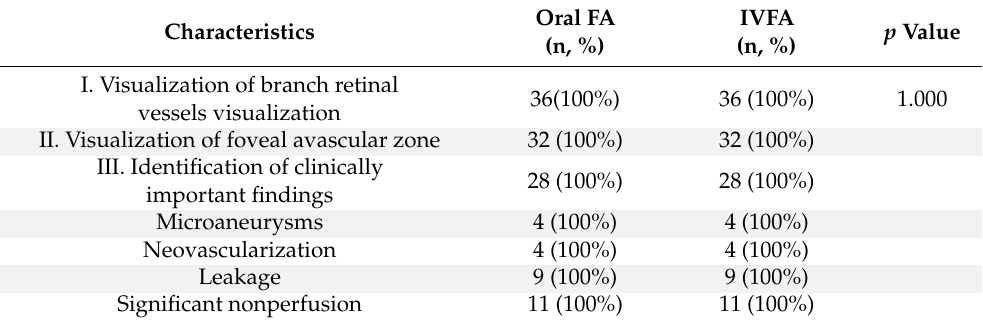
Table 2. Detection rates of retinal vascular characteristics for oral FA and